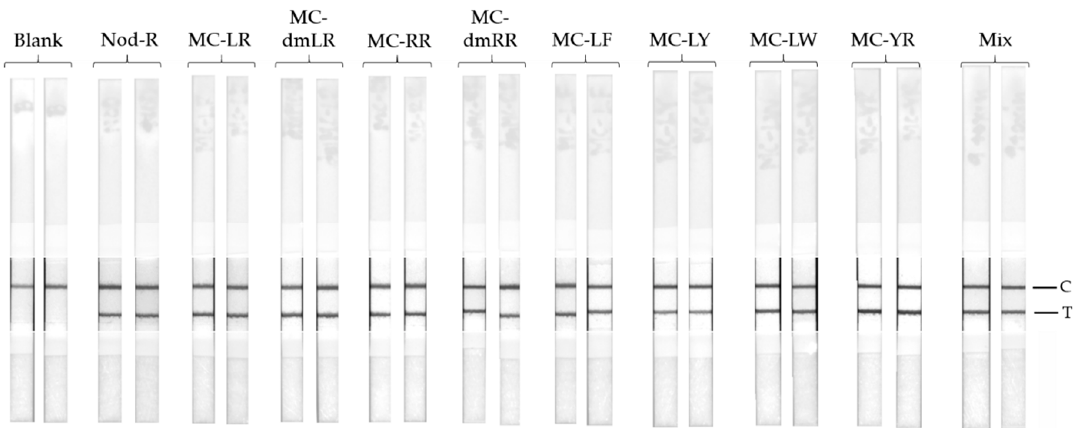
Figure 3. Toxin specificity of the LFIA for nodularin-R(Nod-R), nine different microcystins and a mixture of all toxins. The concentration of each toxin was set to 4 µg/L.